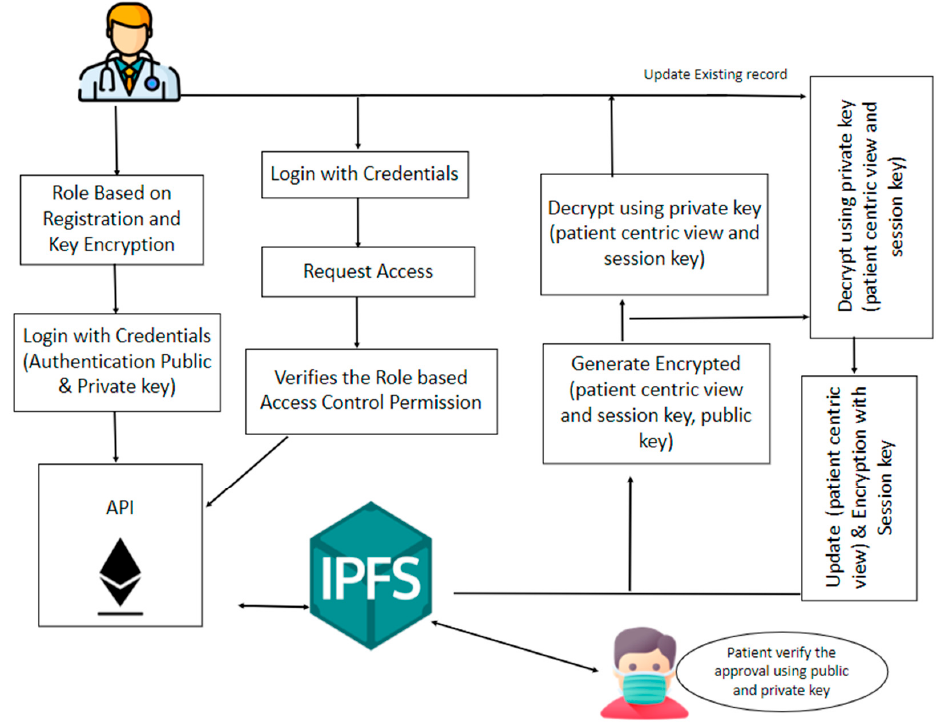
Figure 10. Records